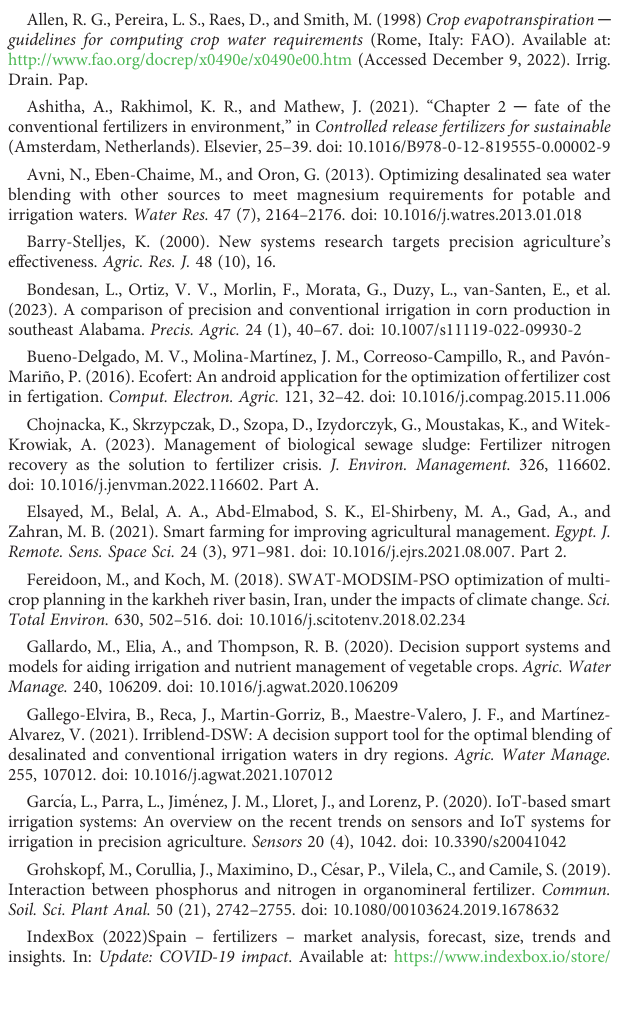
SUPPLEMENTARY FIGURE 2 Registered and available fertilizers.